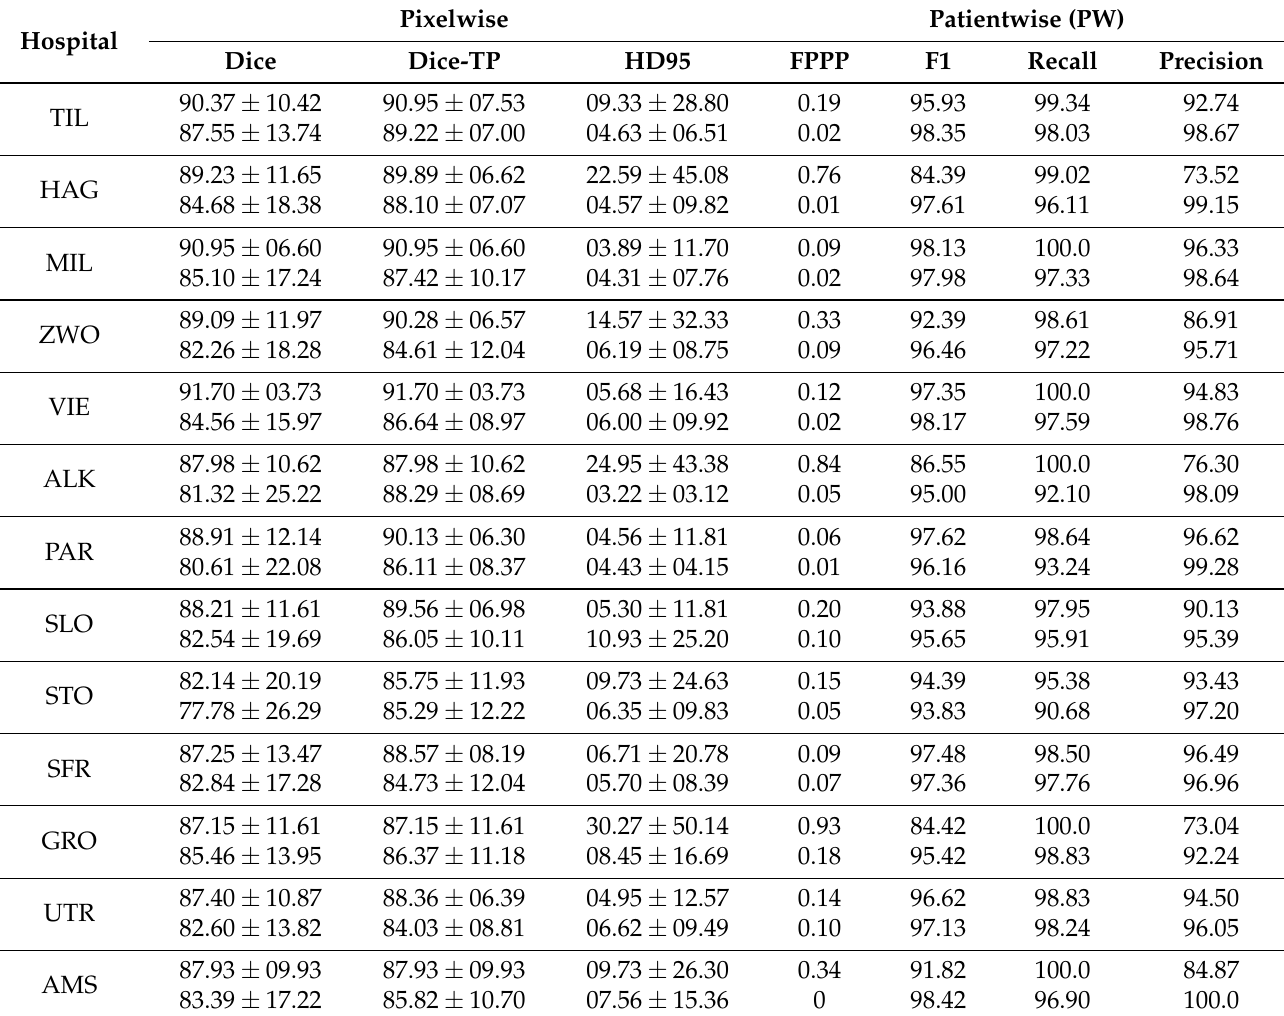
Table 3. Hospitalwise segmentation and detection performance comparison between the two main architectures. For each hospital, the upper row represents nnU-Net and the lower row represents AGU-Net. Pixelwise Patientwise Hospital